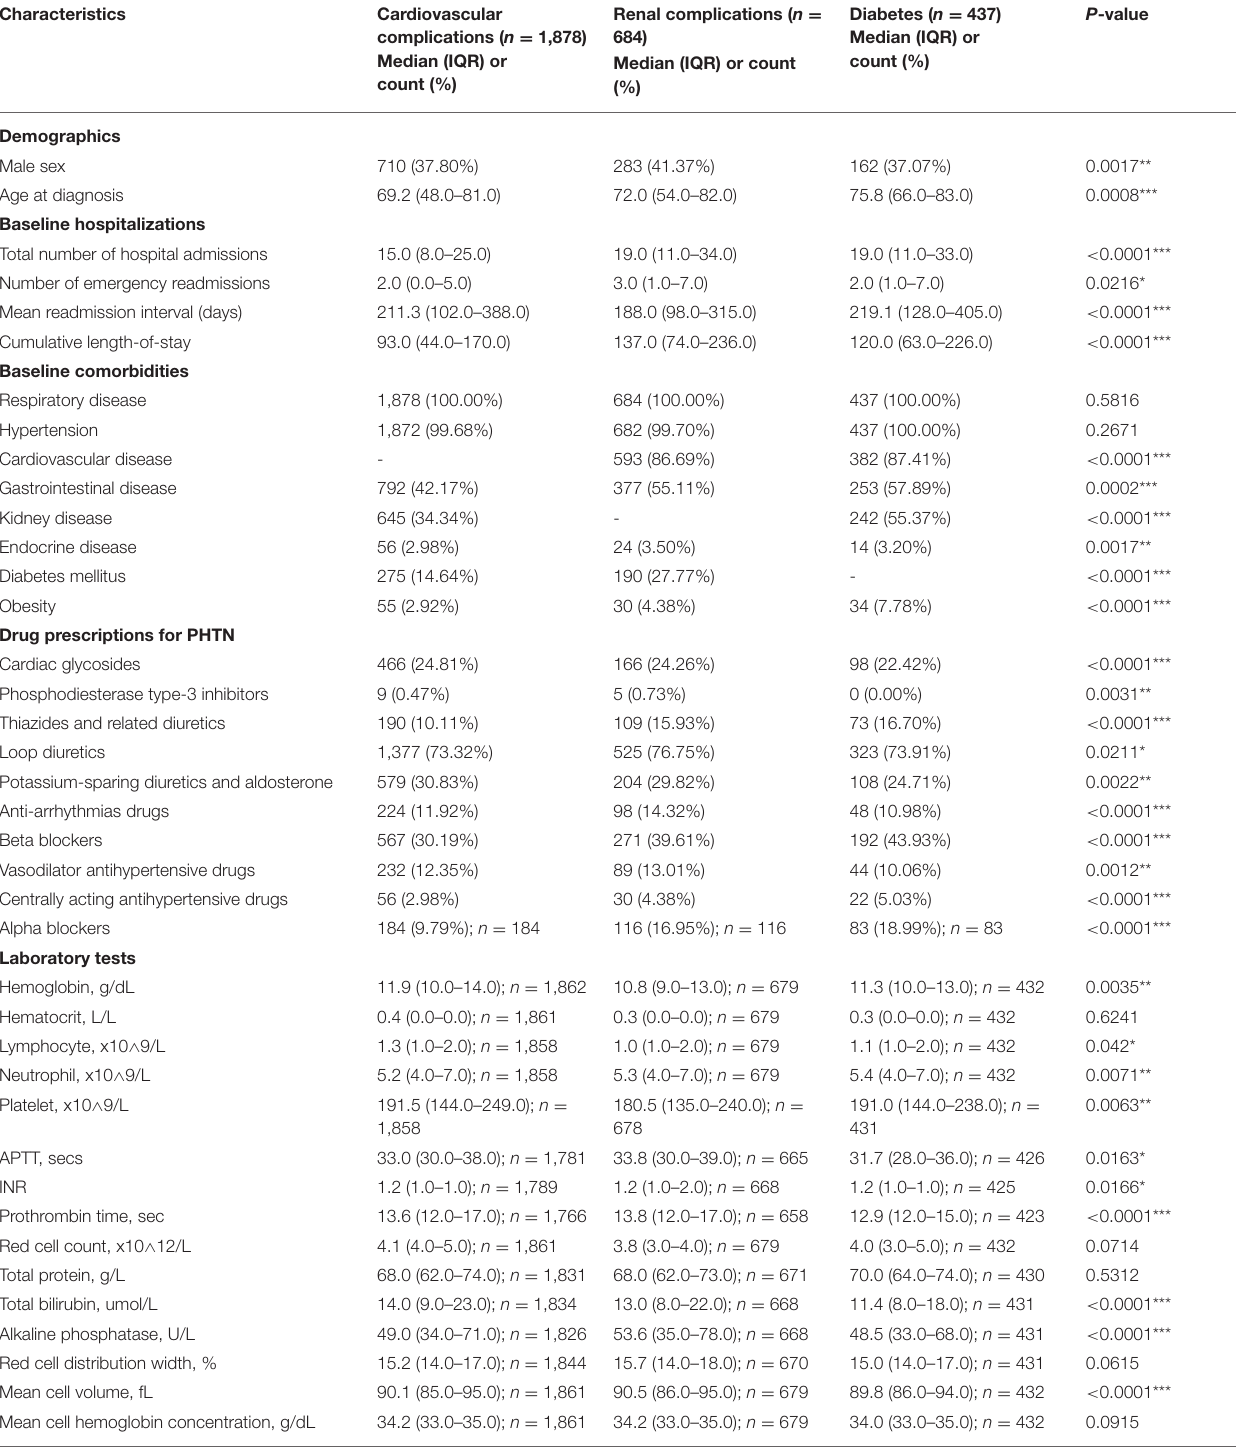
TABLE 2 | The characteristics of patients who developed complications after the diagnosis of pulmonary hypertension.